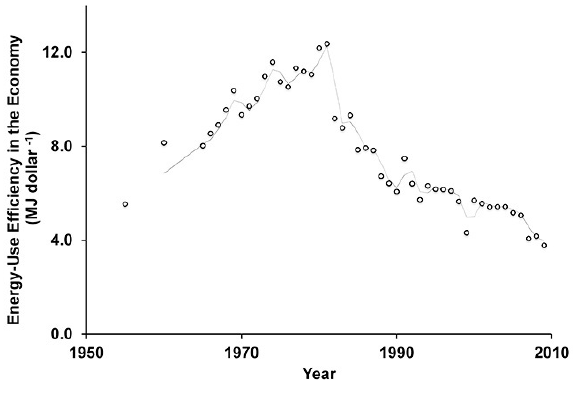
Fig. 3 . The increase in energy use efficiency by the economy of Puerto Rico is illustrated by the increasing economic output in spite of a leveling of the energy